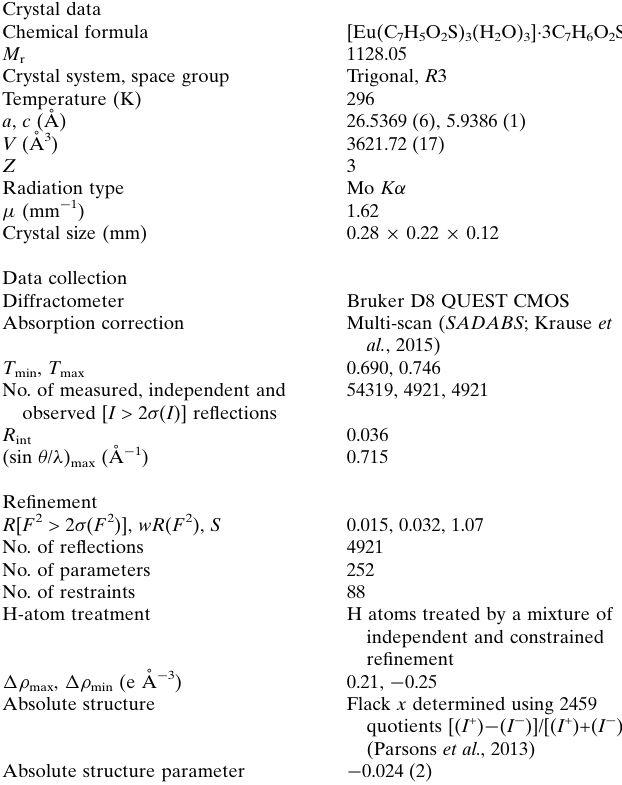
Table 2 Experimental details. Crystal data Chemical